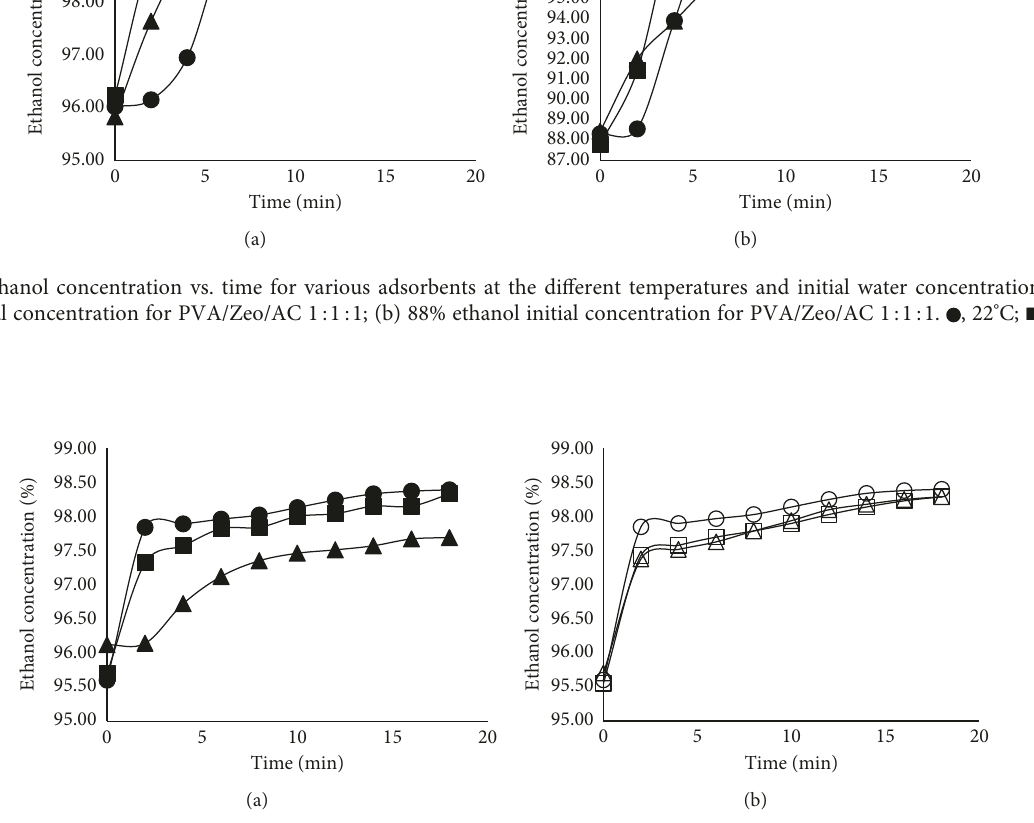
Figure 7: Ethanol concentration vs. time for individual adsorbent (a) at same temperature and different individual adsorbent ( ■ , Zeo at 22 ° C; , AC at 22 ° C; PVA at 22 ° C) and (b) at zeolite individual adsorbent and different temperatures ( , 22 ° C; , 30 ° C; , 40 ° C).